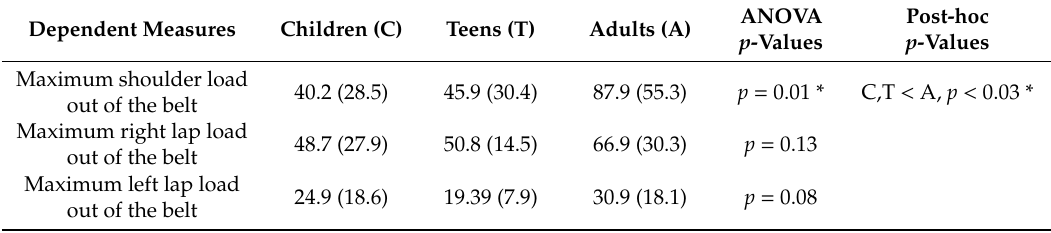
Table 5. Mean (SD) of the maximum seat belt load: e ff ect of age.